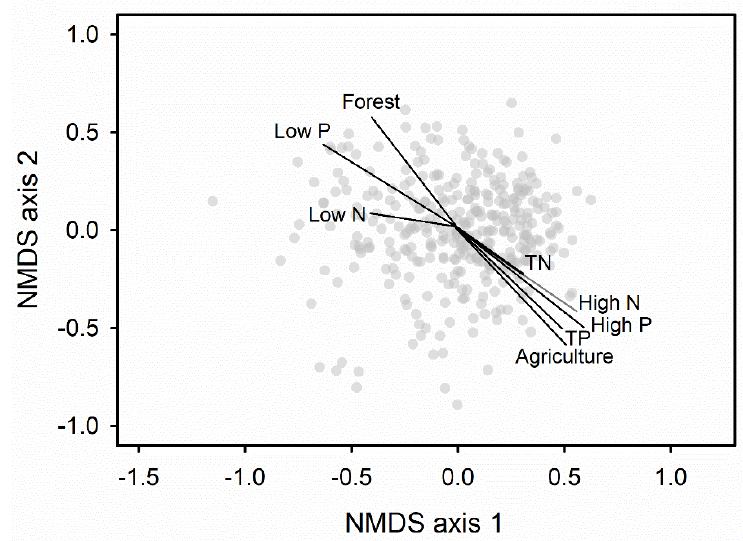
Figure 2. Nonmetric multidimensional scaling ordination showing Spearman correlations of axis scores with total phosphorus (TP), total nitrogen (TN), watershed percent forest, watershed percent agriculture, and relative abundances of low P, low N, high P, and high N bacterial ASVs. Vectors are scaled to span the range of possible correlation coe ffi cients ( − 1 to 1) along NMDS axes.